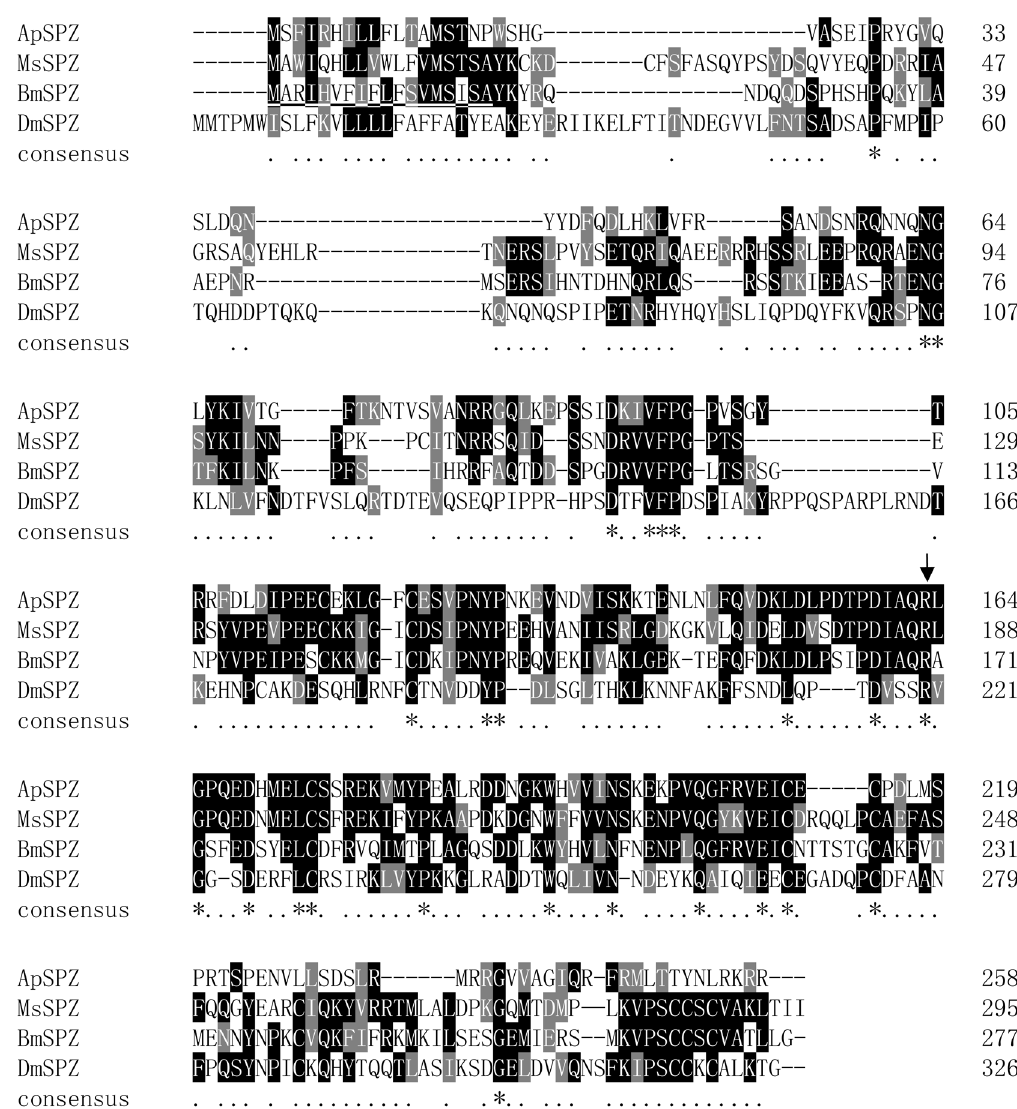
Fig 2. Sequence alignment of spatzles from A . pernyi (ApSPZ), M . sexta (MsSPZ), B . mori and D . melanogaster (DmSPZ). The amino acid alignment was generated by the Clustal X program. Amino acid residues are shaded as follows based on the conserved percent: 100%, (cid:3) 80%, (cid:3) 60% and < 60% according to the default settings are indicated by white letters on black, white letters on dark grey, white letters on light grey and black letters on white, respectively. The predicted signal peptides of proteins from different organisms are underlined. The P1 residue at the activation cleavage site is completely conserved and is noted with an arrow. The GenBank accession numbers are MsSPZ, ACU68553; BmSPZ, NP_001108066; and DmSPZ,